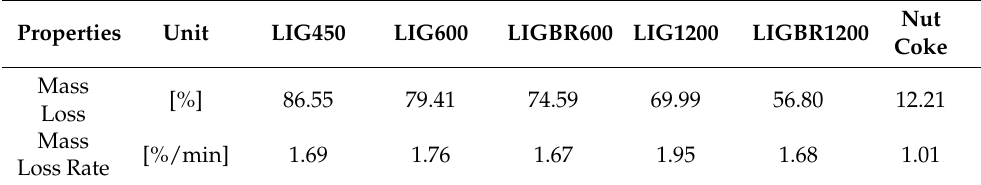
Table 3. Mass loss and mass loss rate values of hydrolysis lignin chars and nut coke in reactivity tests at up to 1350 ◦